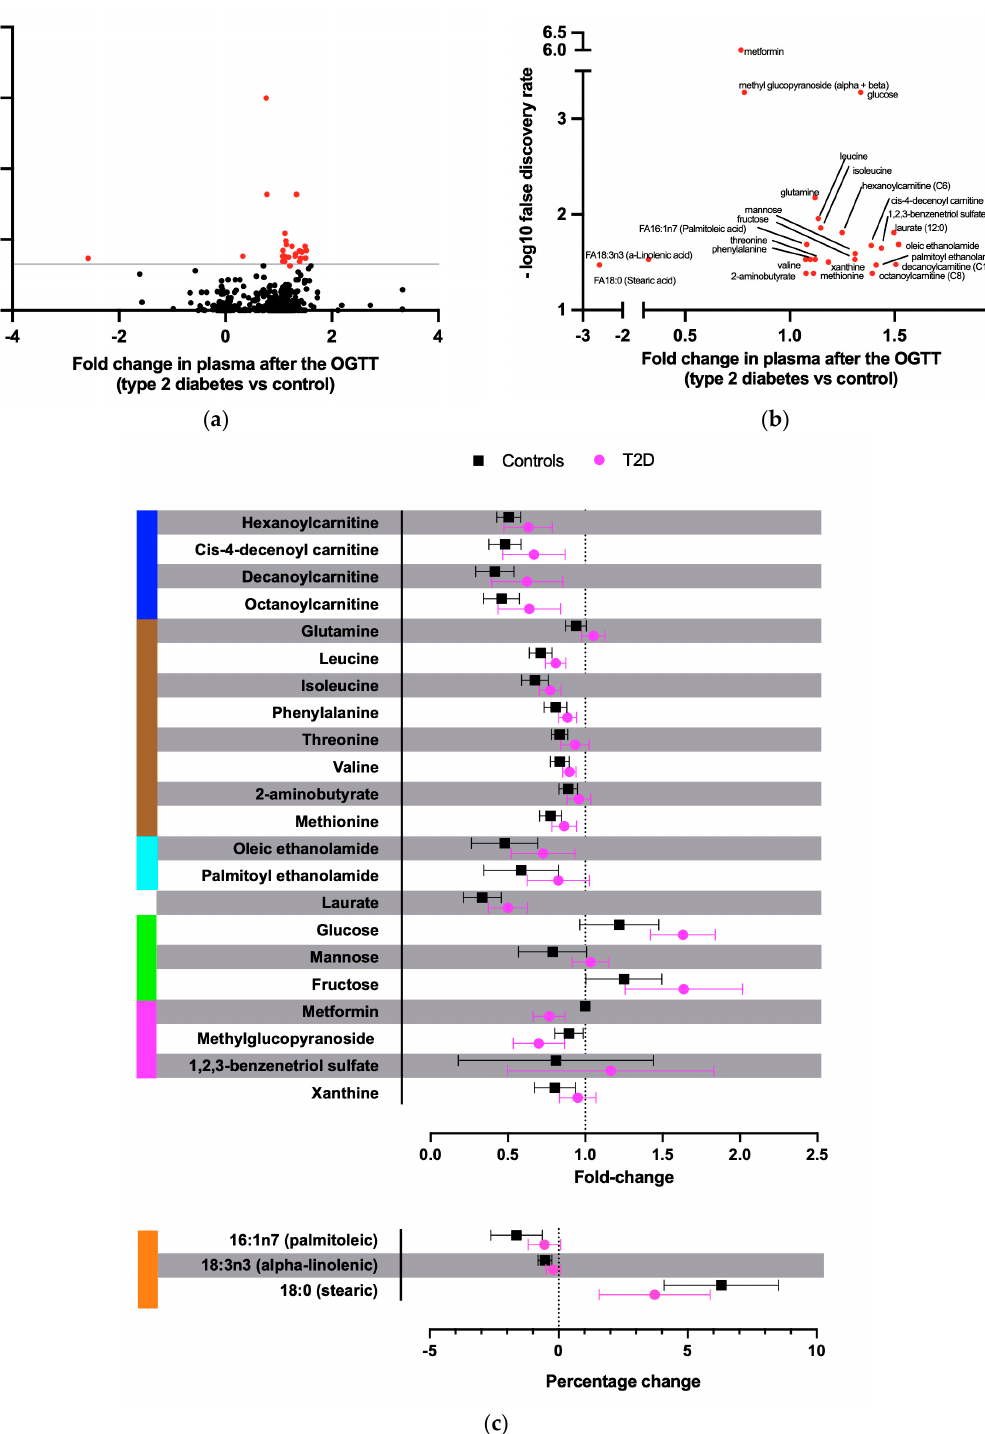
Figure 1. Metabolites with a significantly different fold change after the OGTT between T2D and control subjects. ( a ) Volcano plot of the differences in plasma metabolite concentration changes 90 min after 75 g glucose ingestion between patients with T2D and controls. Y-axis shows –log 10 false discovery rate. Red dots depict significant results. ( b ) Zoom-out on the significant metabolites from panel ( a ). ( c ) Fold and percentage changes of the significant metabolites after the OGTT for T2D and control subjects. In blue, acylcarnitines; in brown, amino acids; in light blue, acyl ethanolamides; in green, monosaccharides; in magenta, xenobiotics; in orange, free fatty